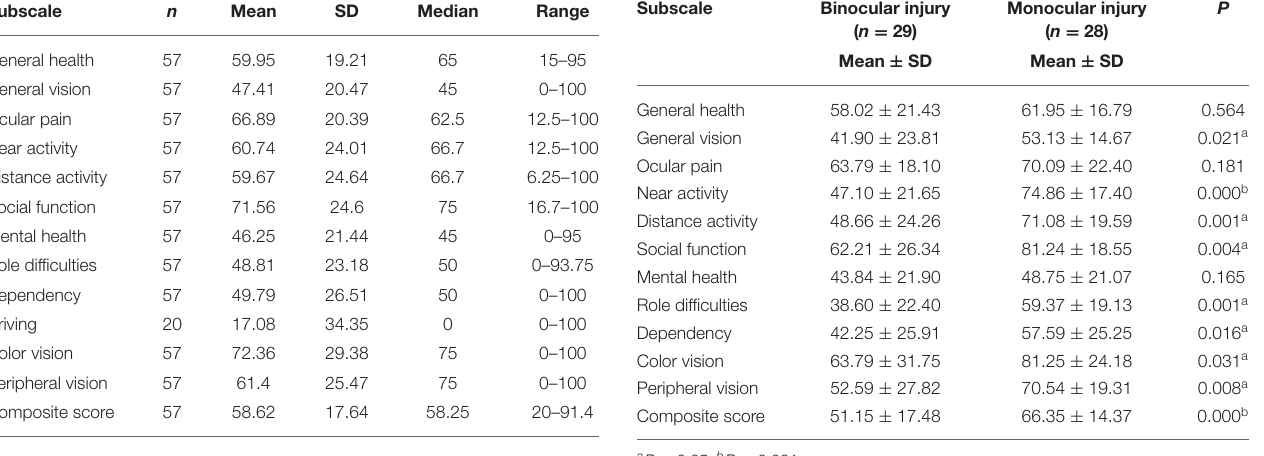
TABLE 2 | Mean scores for each subscale and composite scores of VFQ-39 in all subjects. Subscale n